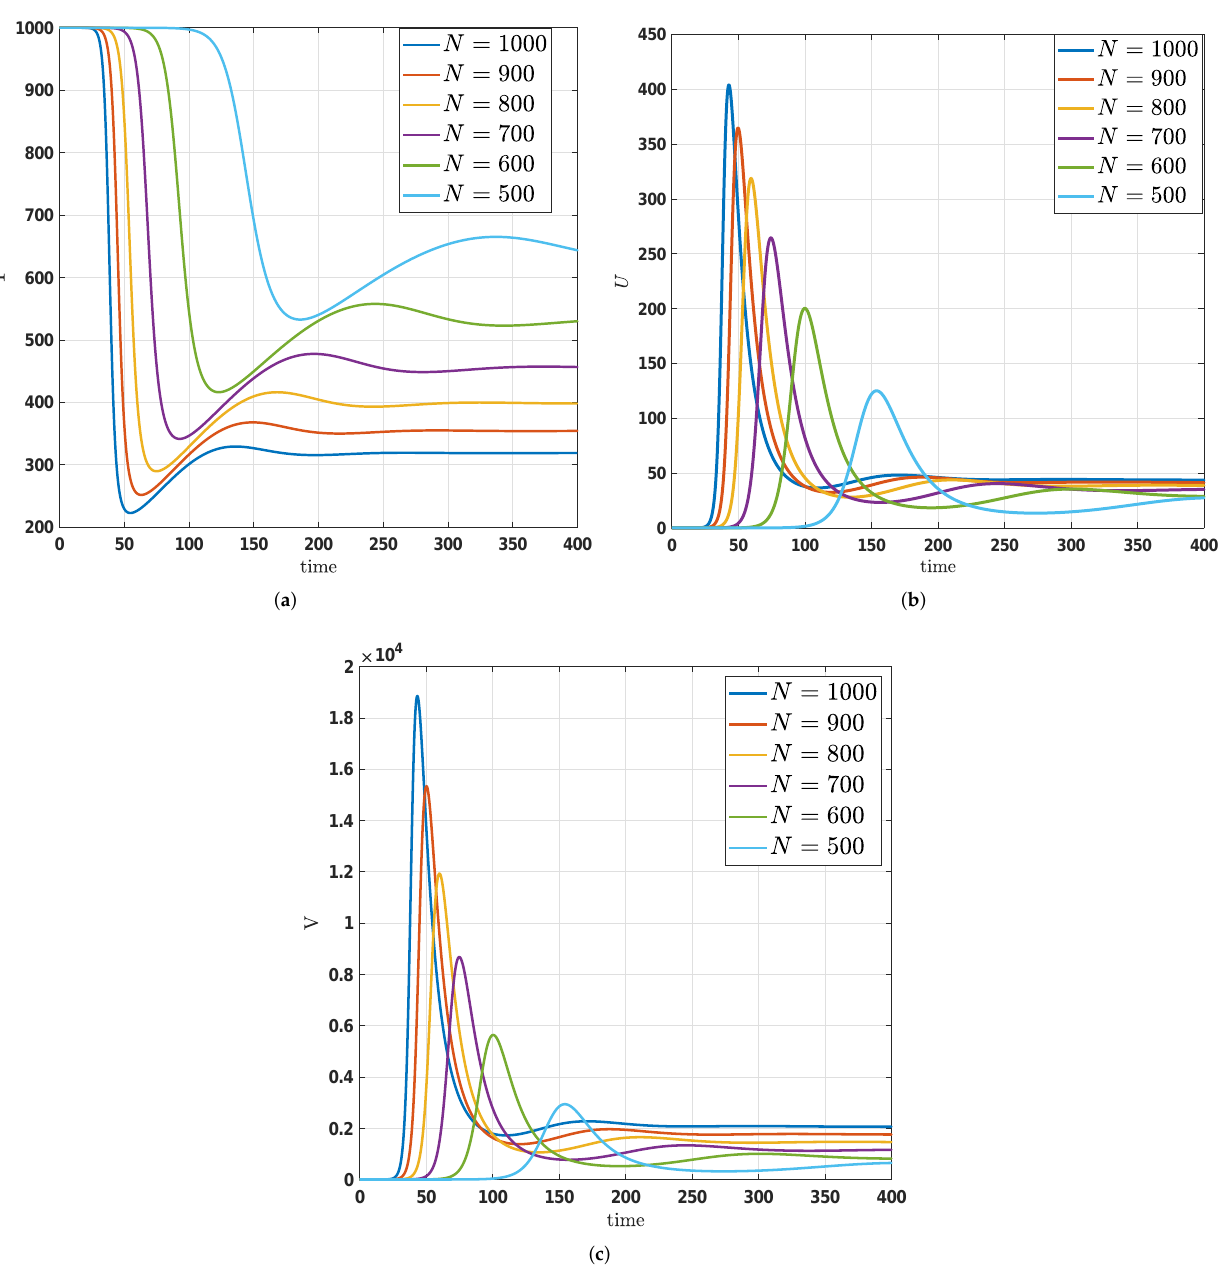
Figure 5. Numerical trajectories by varying the average number of infected particles N under the fractal order and fractional order δ = σ = 0.95 via the Adams-Bashforth method. ( a ) The effects of N on T . ( b ) The effects of N on U . ( c ) The effects of N on V